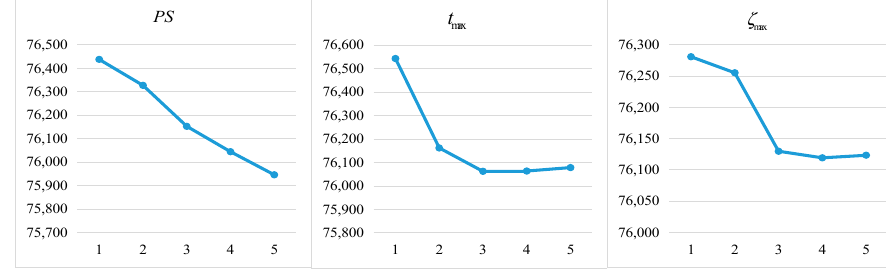
Figure 3. Factor level trend of parameters. Table 1. Parameter levels.